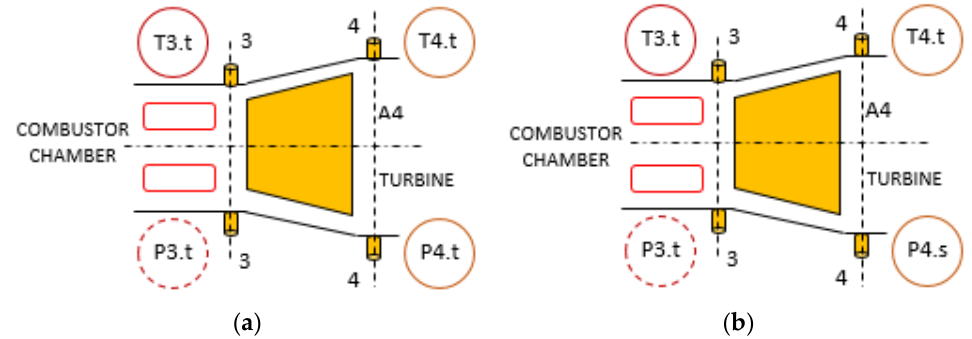
Figure 3. Turbine instrumentation method scheme, model ( a ); turbine instrumentation method scheme, model ( b ).